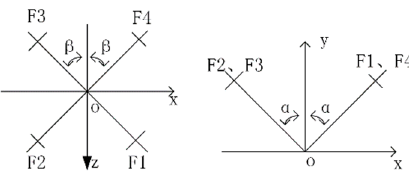
Figure 2. Pyramid allocation of a flywheel system (FS).